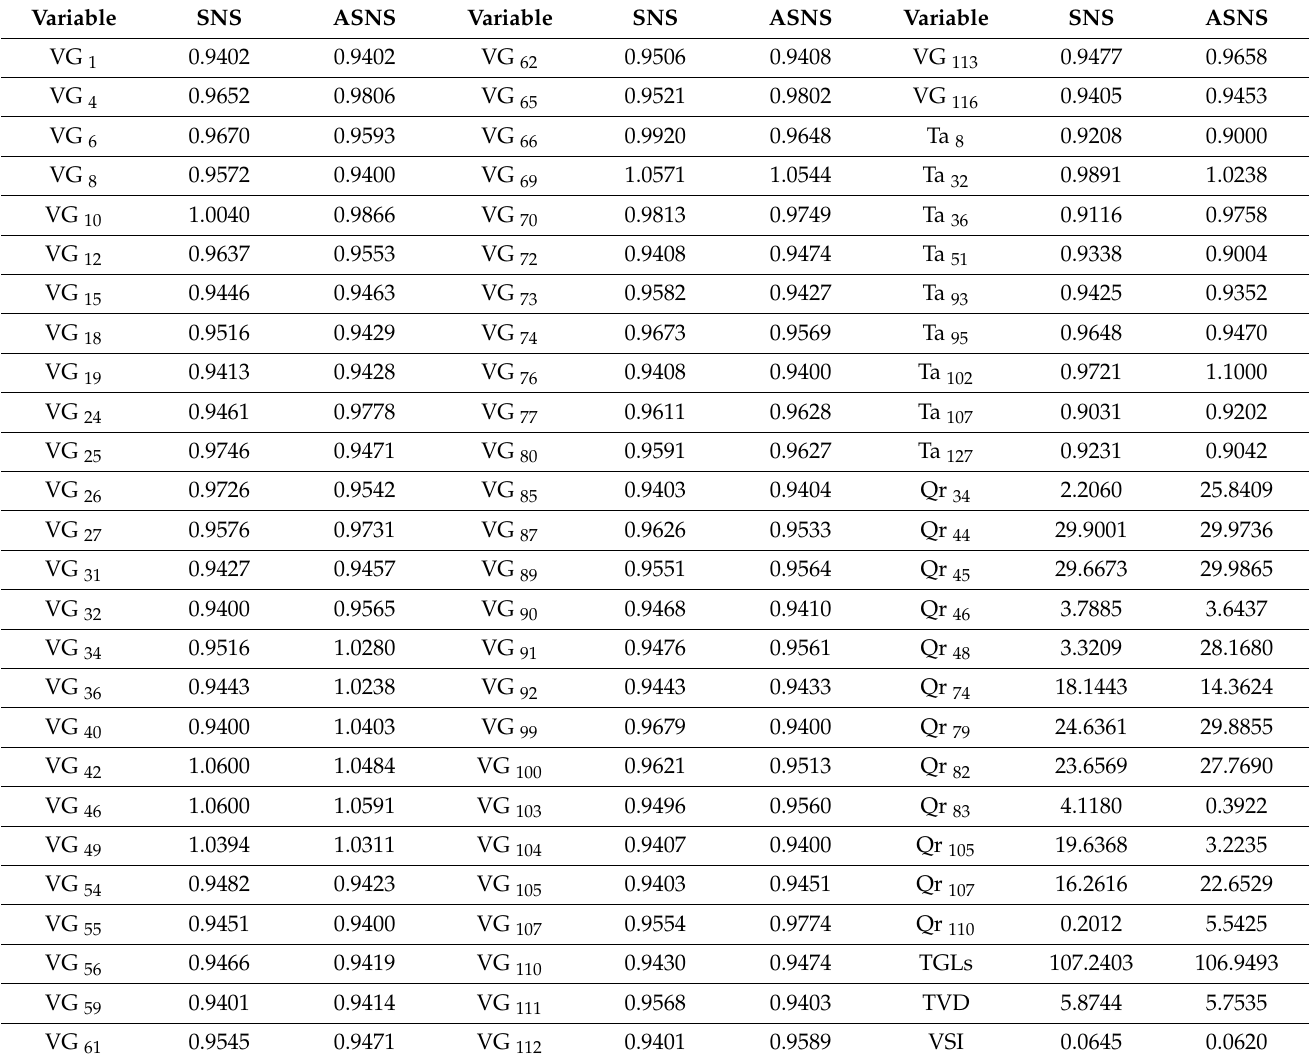
Table 12. Optimal results for Case 3 of the IEEE 118-bus